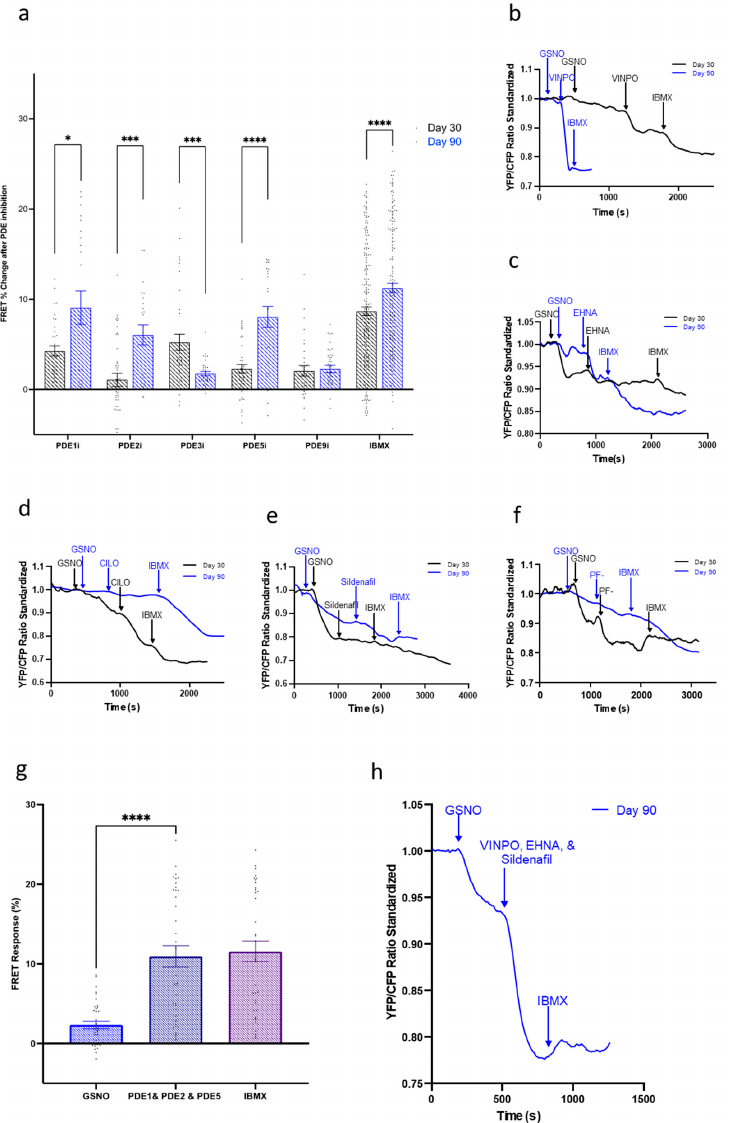
Figure 5. ( a ) Regulation of the nitric oxide (NO)-cGMP pathway by PDEs during aging of IMR-hPSC-CMs from day 30 to day 90. Model traces of cGMP production after stimulation via S-Nitrosoglutathione (GSNO) and subsequent ( b ) PDE1 inhibition via vinpocetine (VIMPO), ( c ) PDE2 inhibition via EHNA, ( d ) PDE3 inhibition via Cilostamine (CILO), ( e ) PDE5 inhibition via Sildenafil, and ( f ) PDE9 inhibition via PF-04447943 (PF-), and saturation via 3-isobutyl-1-methylxanthine (IBMX). ( g , h ) Bar chart ( g ) and model trace ( h ) illustrating the effect of simultaneous PDE1, PDE2, and PDE5 inhibition after NO-cGMP pathway stimulation via GSNO.